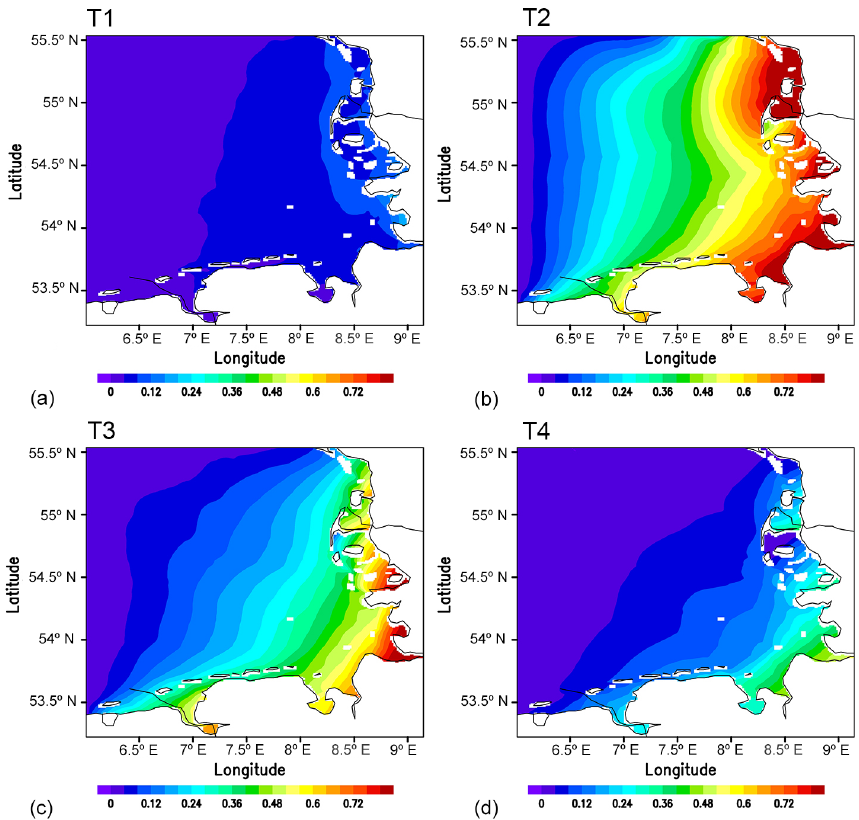
Figure 13. Maximum surge differences between FULL and 2-D runs in (m) for T1–T4 tidal periods as shown in Fig. 9.